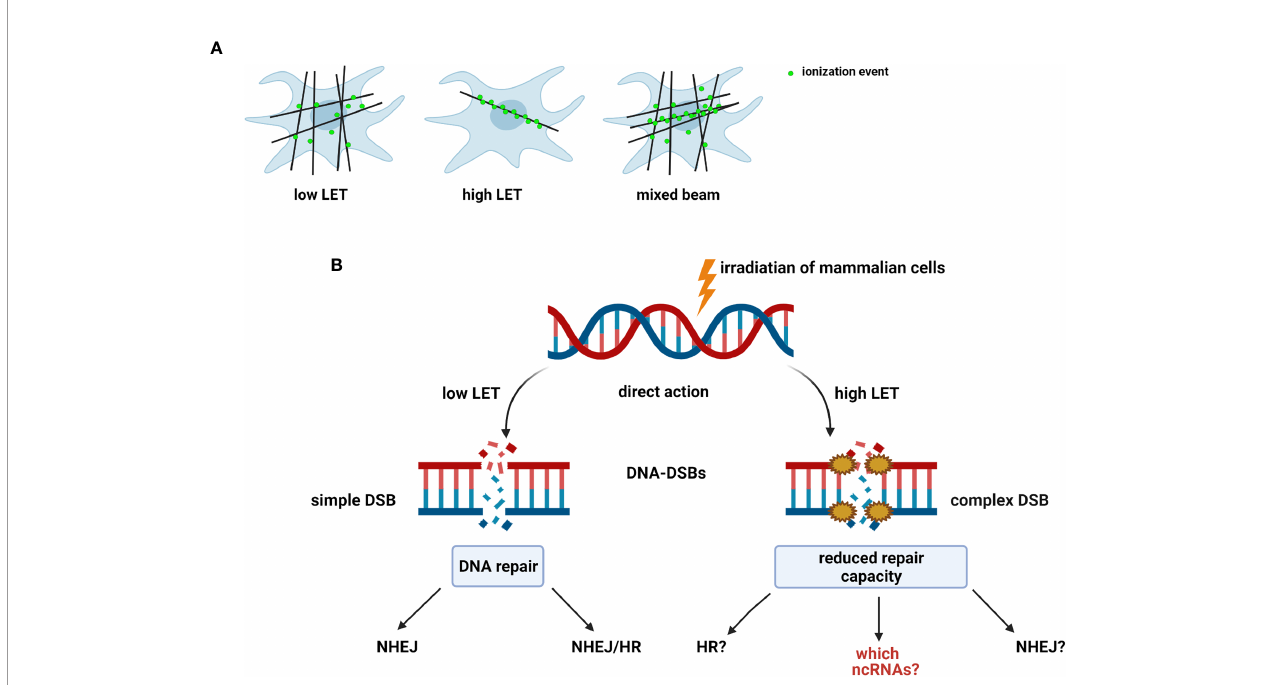
FIGURE 1 | (A) Types and effect of radiation according to linear energy transfer (LET): Low-LET radiation produces sparse ionization along its track, homogeneously within a cell. High-LET radiation causes dense ionization along its track. Mixed beam — both effects observed within a single cell (11, 12, 16, 17). (B) Radiation-induced DNA damage: DSBs induced by low-LET radiation are repaired by non-homologous end-joining pathway (NHEJ) alone or NHEJ and homologous recombination (HR). Mechanisms of repair of complex DSBs induced by high-LET radiation are not fully determined (9). Created with